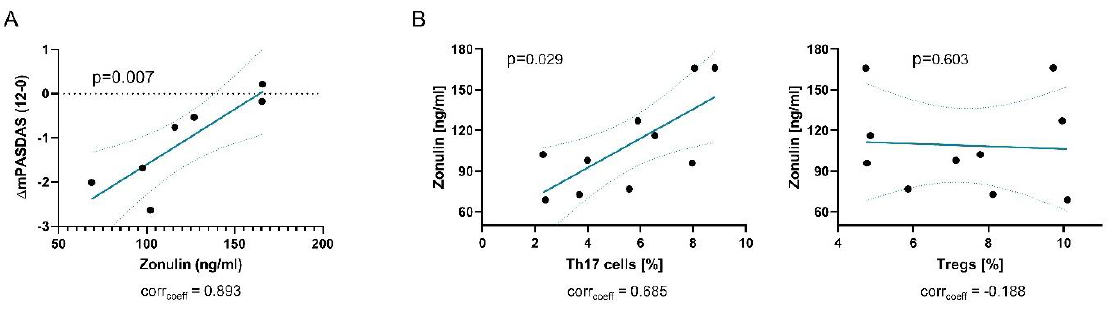
Figure 3. Intestinal permeability is a predictor for probiotics effect. Graphs show ( A ) correlation of the change of PASDAS from baseline to week 12 with zonulin; ( B ) correlations of zonulin with the frequency of Th17 cells (left) and Tregs (right).